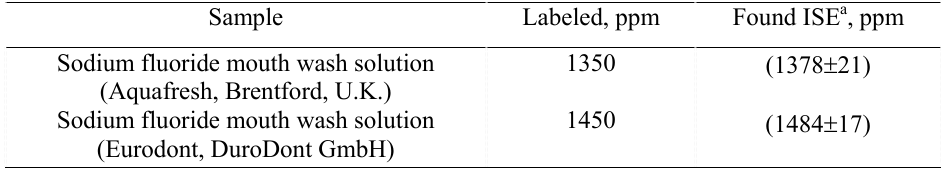
Table 4. Fluoride ions determination in mouth wash